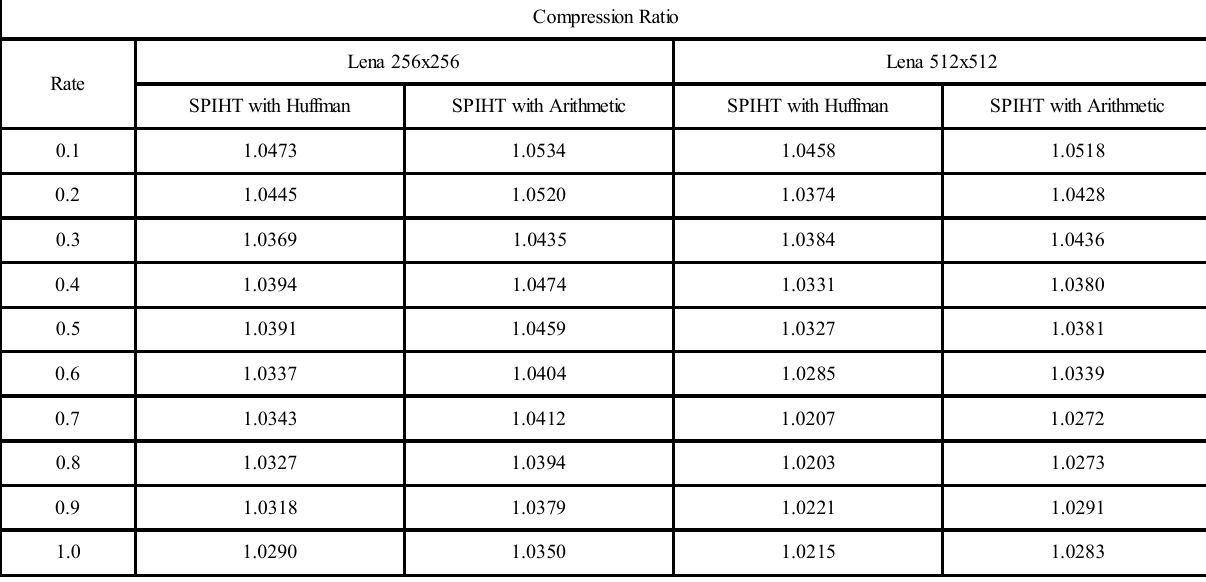
TABLE 7. COMPRESSION RATIOS OF BOTH ALGORITHMS